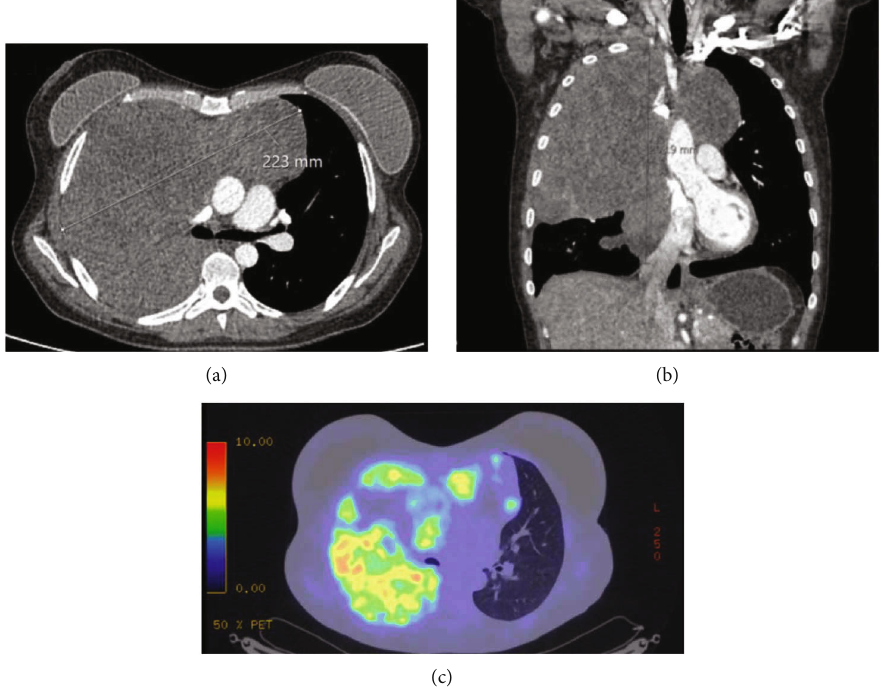
Figure 1: (a) Axial and (b) coronal computed tomography of the thorax showing a tumour invading the right lung, occupying most of the right hemithorax, and crossing the midline to the left side of the mediastinum. (c) 18 F- fl uorodeoxyglucose positron emission tomography integrated with computed tomography showing heterogeneous radiotracer uptake in the tumour, with maximum standardized uptake value of 13.1 and areas of